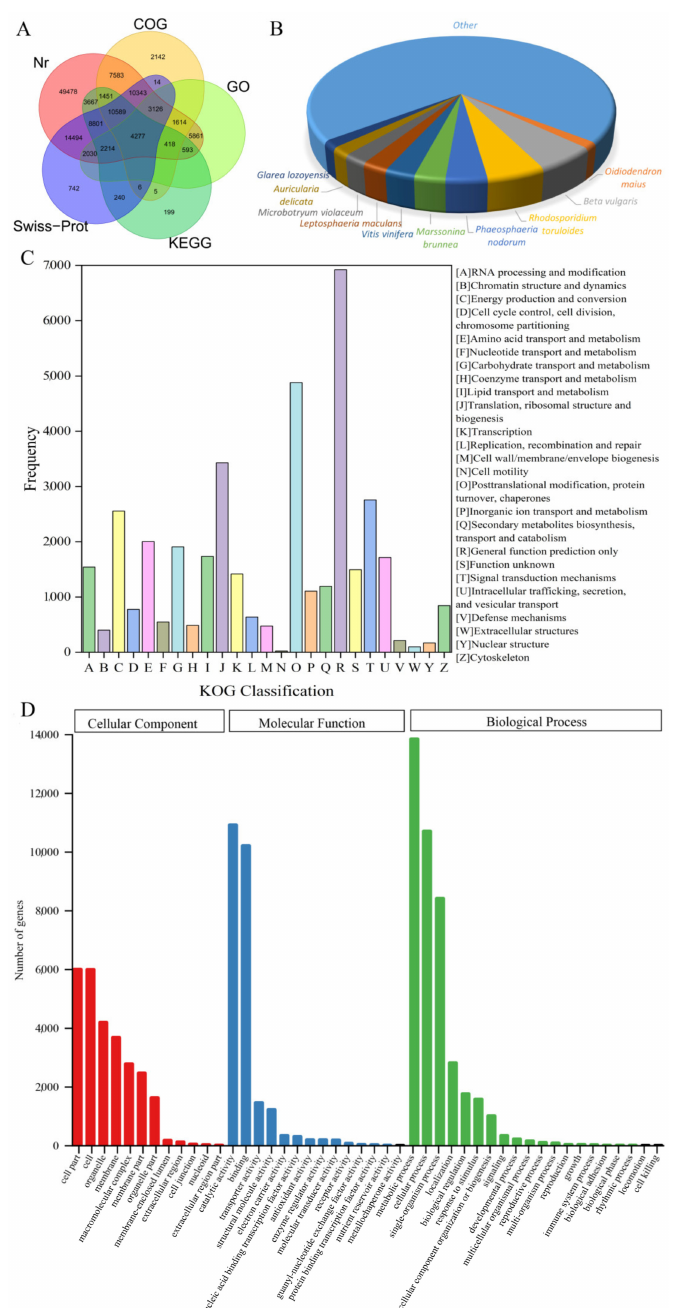
Figure 1. Functional annotation of assembled unigenes. ( A ) Venn diagram for the unigenes annotated by five different databases. The integration of best similarity search results against the NCBI non- redundant protein (Nr), Swiss-Prot, Clusters of Orthologous Groups (COG), Gene Ontology (GO), and Kyoto Encyclopedia of Genes and Genomes (KEGG) databases. ( B ) Species distribution of the annotated unigenes from R. officinale in Nr dataset. ( C ) euKaryotic Ortholog Group (KOG) classification. The assembled unigenes were classified into 25 categories in the KOG classification. The x -axis indicates the KOG classification, and the y -axis indicates the number of unigenes in the category. ( D ) Gene ontology (GO) classification. GO is summarized into three main categories: cellular component, molecular function, and biological process. The y -axis indicates the number of unigenes in the category, and the x -axis indicates the GO